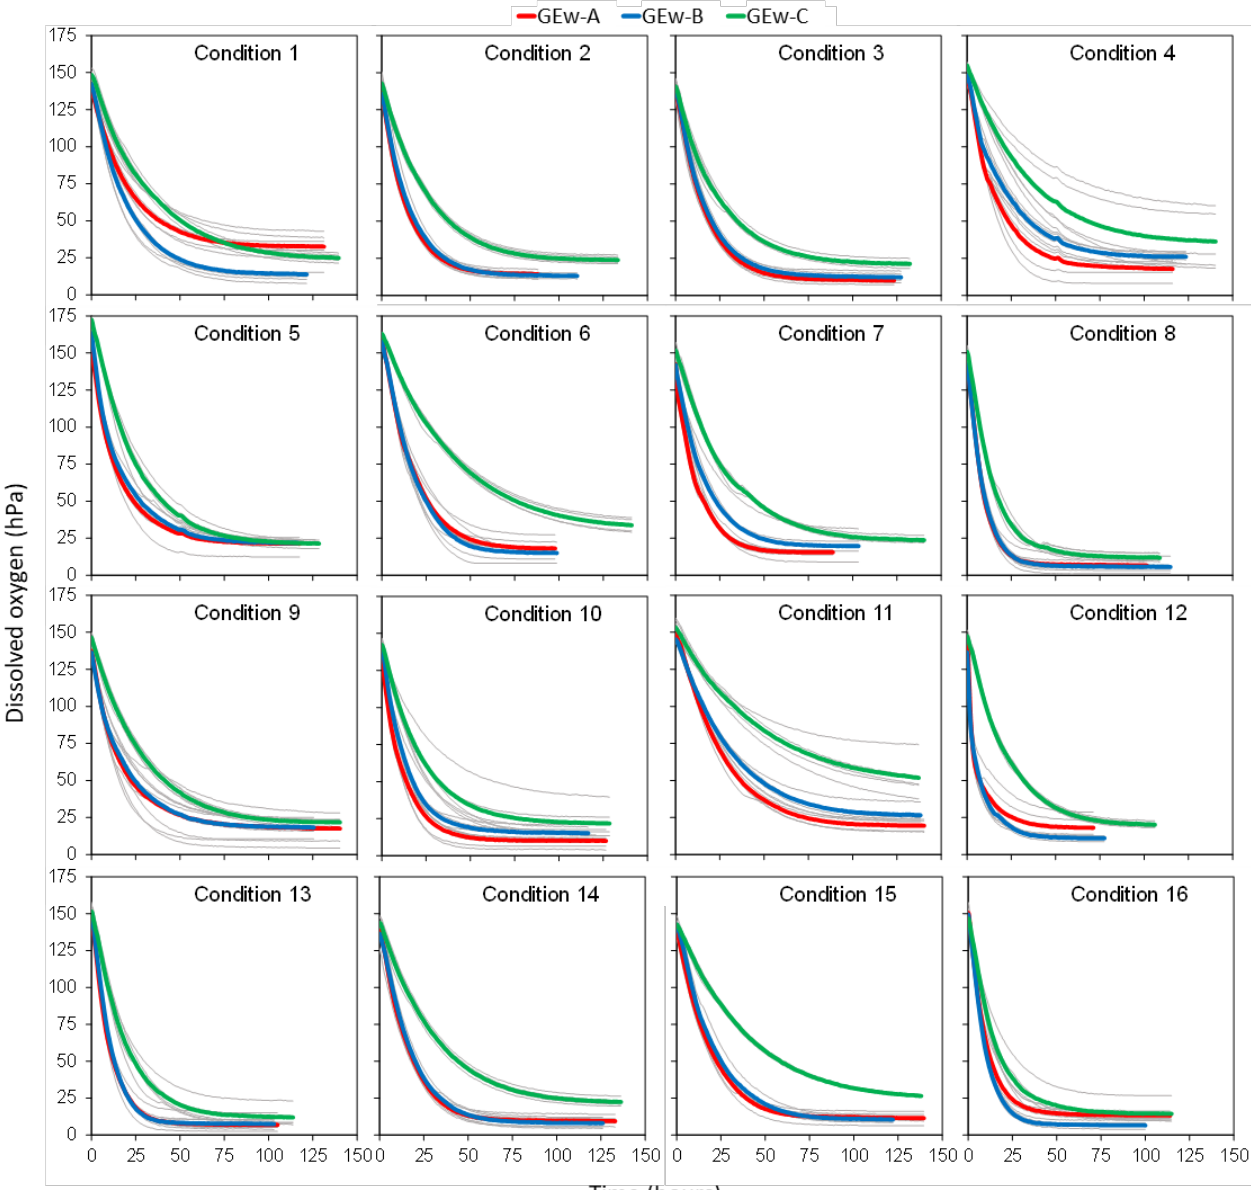
Figure 1. Each one of the 16 graphs represents the oxygen kinetic of a different experimental condition (Table 1). On each graph, the average oxygen kinetics Gew-A, Gew-B and Gew-C were represented in red, blue, and green, respectively, while the 5 replicates of each GEw are shown in gray. Given that the aim of this work was to determine the reconstitution condition that allowed the greatest differentiation between the GEws under study based on the greatest differentiation between their oxygen consumption kinetics, an ANOVA was performed to compare the GEws in pairs on the basis of the parameters obtained in each of the oxygen consumption kinetics of the 16 conditions tested. Thus, it was analyzed whether in condi- tion 1 there were statistically significant differences for the parameters of the consumption kinetics that defined GEw-A and GEw-B, obtaining the corresponding p -level A – B . We also inquired whether there were differences between GEw-A and GEw-C, obtaining the cor- responding p -level A – C ; and finally, between GEw-B and GEw-C, obtaining the correspond- ing p -level B – C . The worst significance, that is, the highest p -level among the three obtained ( p -level A – B , p -level A – C or p -level B – C ) was selected as the aptitude indicator for each of the